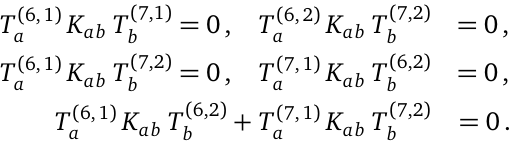
Figure 2: Charge distributions created by the operator d set the lattice spacing as ε lattice